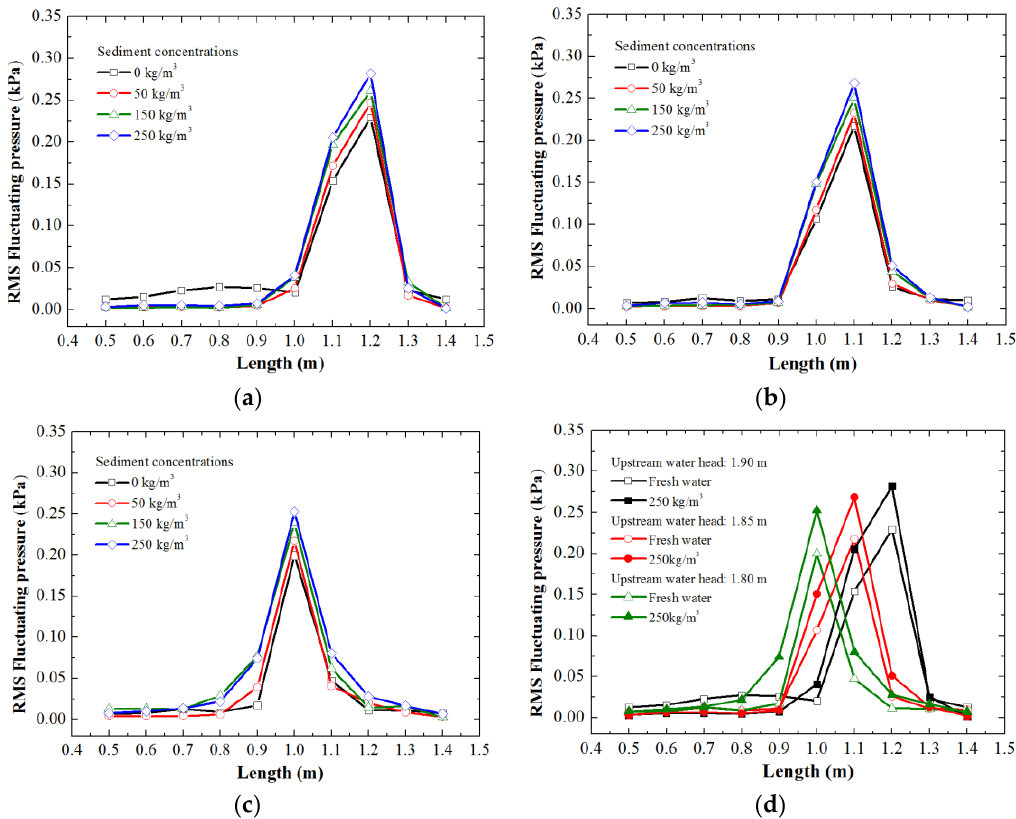
Figure 8. Relationship between fluctuating pressure and upstream water head for different concentrations of sediments: ( a ) Upstream water head of 1.90 m; ( b ) upstream water head of 1.85 m; ( c ) upstream water head of 1.80 m; ( d ) comparison of pressures measured at different upstream water heads for fresh water and sediment-laden flow of 250 kg/m 3 in concentration.